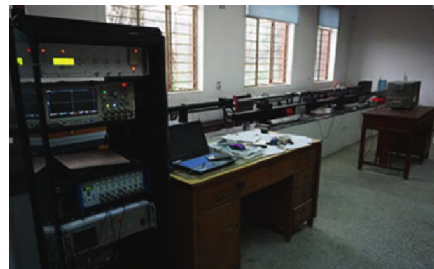
Figure 1: SHPB test apparatus system.